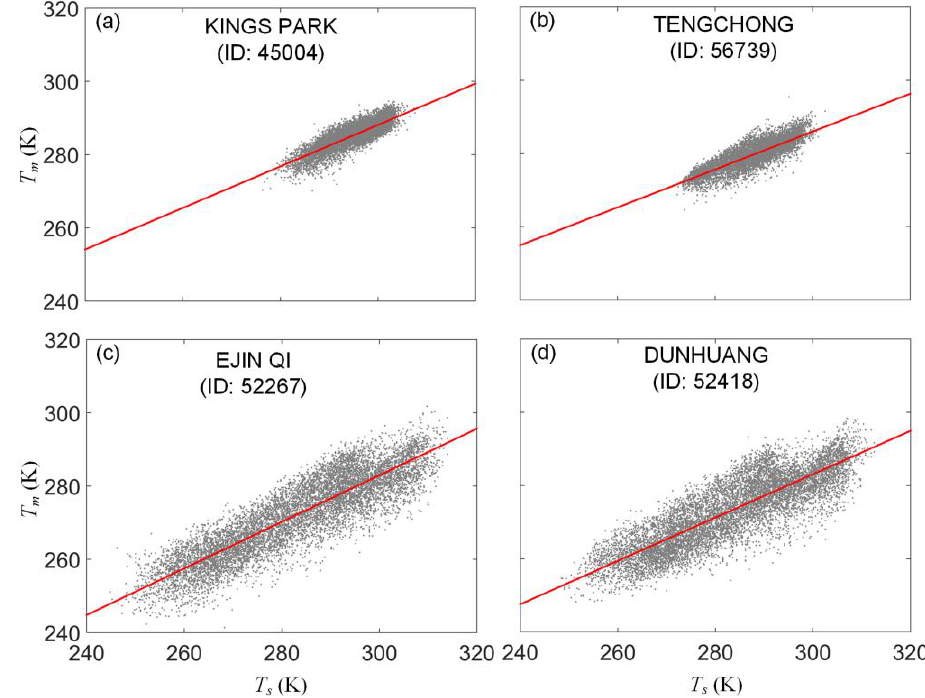
Figure 7. Radiosonde data points (gray dots) and T s ∼ T m linear regression models (red lines) at the station ( a ) Kings Park, ( b ) Tengchong, ( c ) Ejin Qi, and ( d ) Dunhuang. There are 10,054 profiles used at Kings Park, 9933 profiles at Tengchong, 9568 profiles at Ejin Qi, and 9907 profiles at Dunhuang.